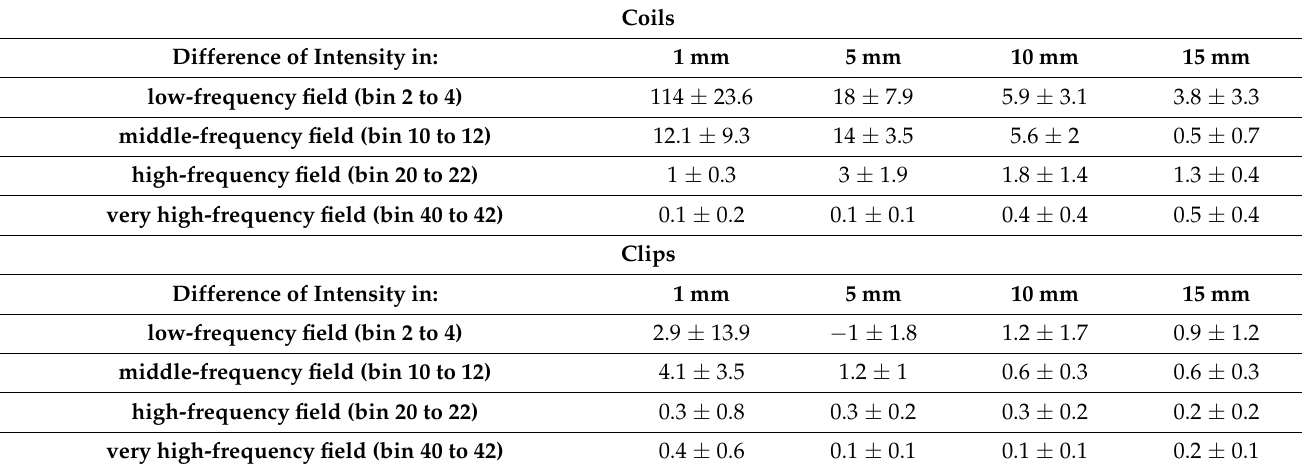
Table 2. Results of the intensity- and frequency-analysis of the quantitative image evaluation: differences of intensity in the four representative frequency fields in four different distances and the mean intensity in all frequency fields and all distances. Data shows mean ± standard deviation.